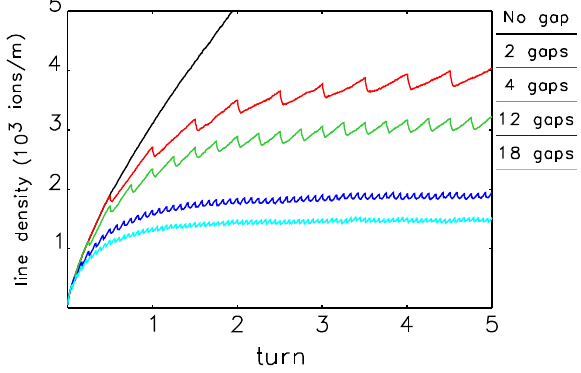
FIG. 22. Simulated ion density (averaged around the ring) for 50% NEG coating, round beams, 200 mA, 1000 Ah and 2-bunch gaps. Only the first few turns are shown.